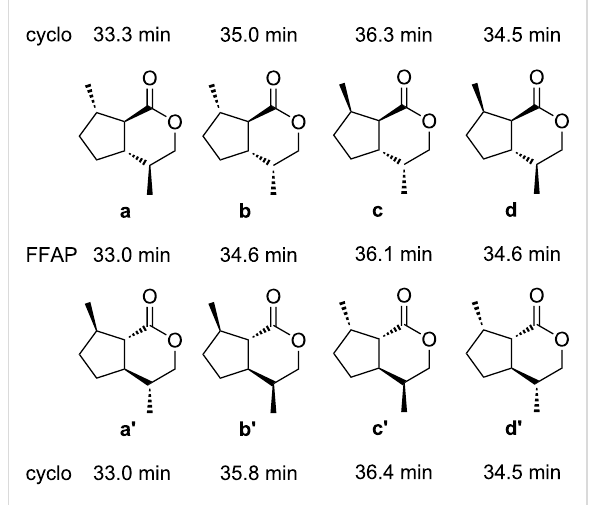
Figure 3: Structures and gas chromatographic retention times of trans - fused dihydronepetalactones on a conventional FFAP column (FFAP) and on an enantioselective cyclodextrin column (cyclo). For experi- mental details see Supporting Information File 1. The racemates b / b' and d / d' , which coeluted on FFAP, could be separated from each other on DB5 (data not shown).